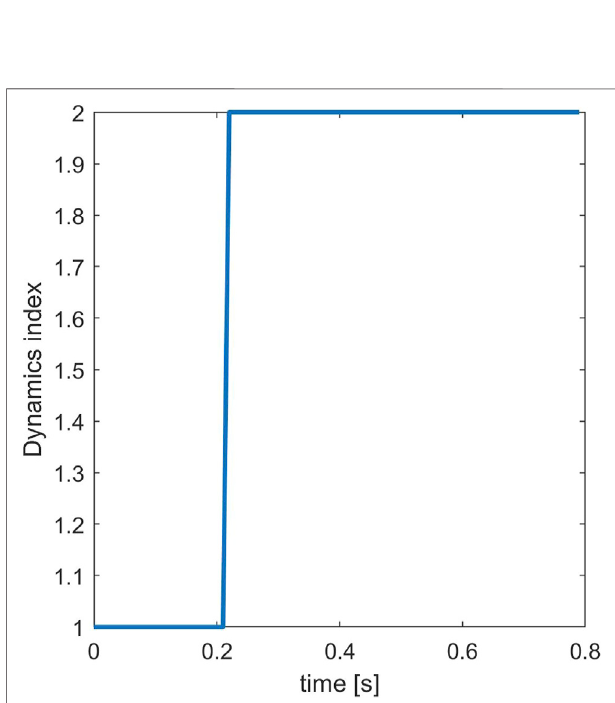
FIGURE 7 | Switching signal of a representative subject in DT condition. Dynamic index i corresponded to the i th autoregressive with exogenous input (ARX) dynamic fi tted with the i th data cluster, for i (cid:1) 1,2. The signal shows one switch, and in this case, the second dynamic occurred at 230